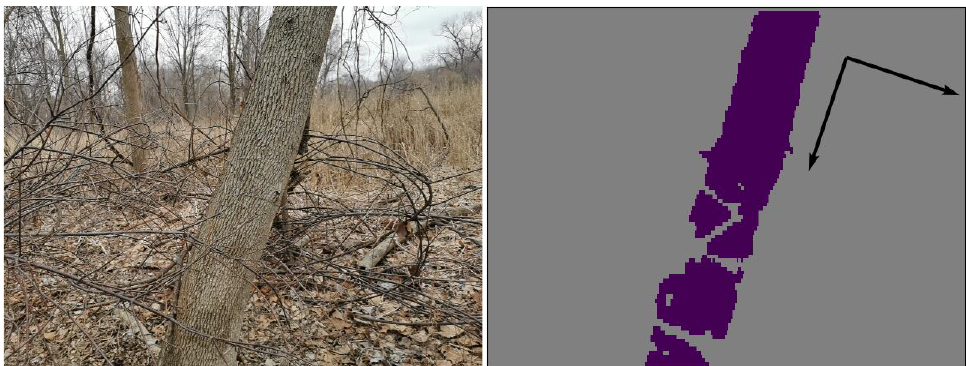
Figure A1. The eigenvectors found by PCA can be used to robustly identify the principal axis of a highly tilted trunk. ( Left ) RGB image. ( Right ) Binary version of I s , with eigenvectors overlaid as black